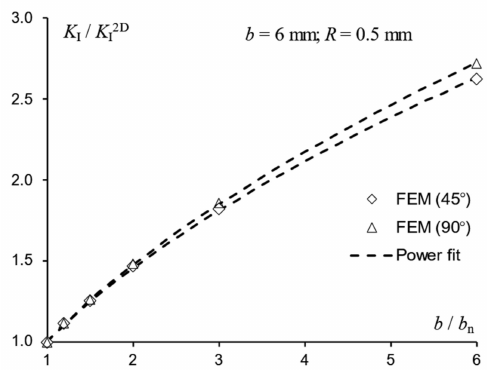
Figure A4. Approximation of the numerical data for the normalized average stress intensity factor by a power